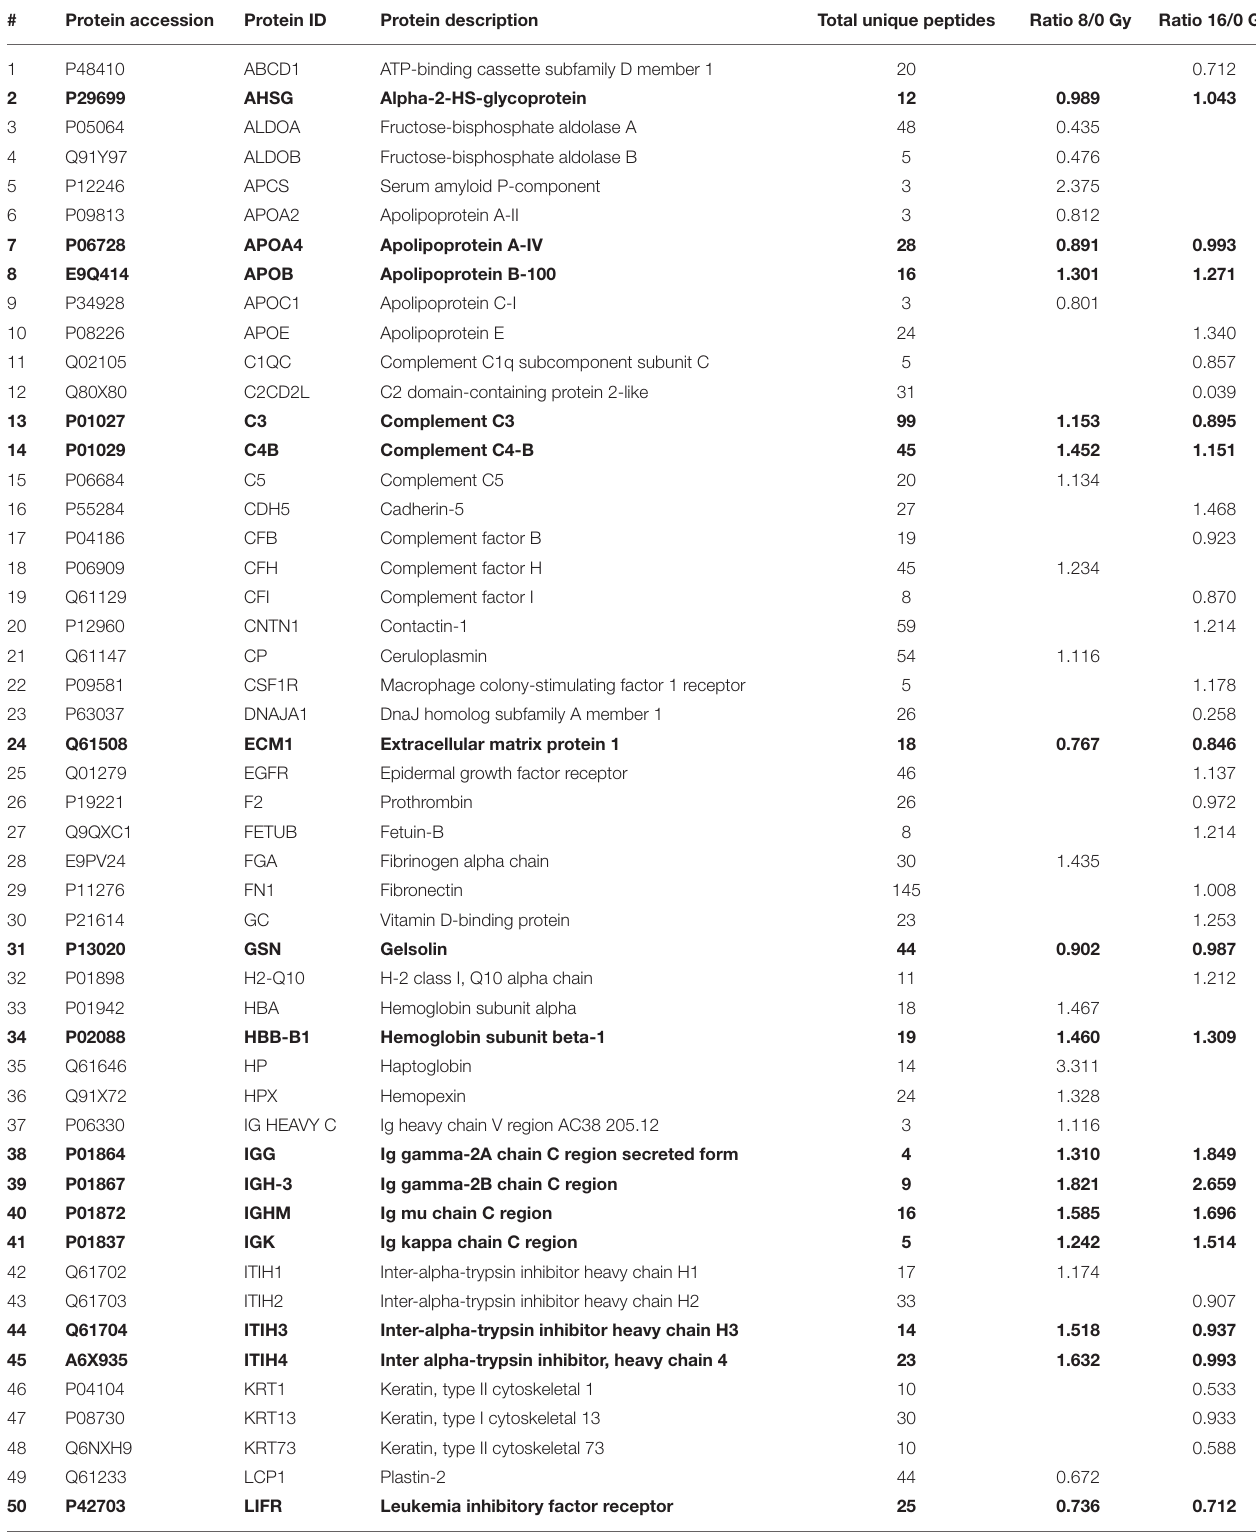
TABLE 1 | Significantly deregulated serum proteins in heart-irradiated